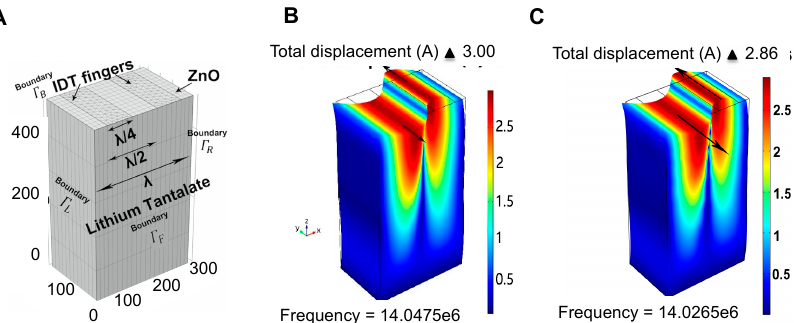
Figure 1. A 3D COMSOL model and simulation results based on the 36°Y-cut LiTaO3: ( A ) 3D cell model geometry with mesh; ( B ) resonance frequency of the IDTs with a 200 nm thick ZnO layer; and ( C ) resonance frequency of the IDTs with 12.5 K cells media on the 200 nm thick ZnO layer surface.